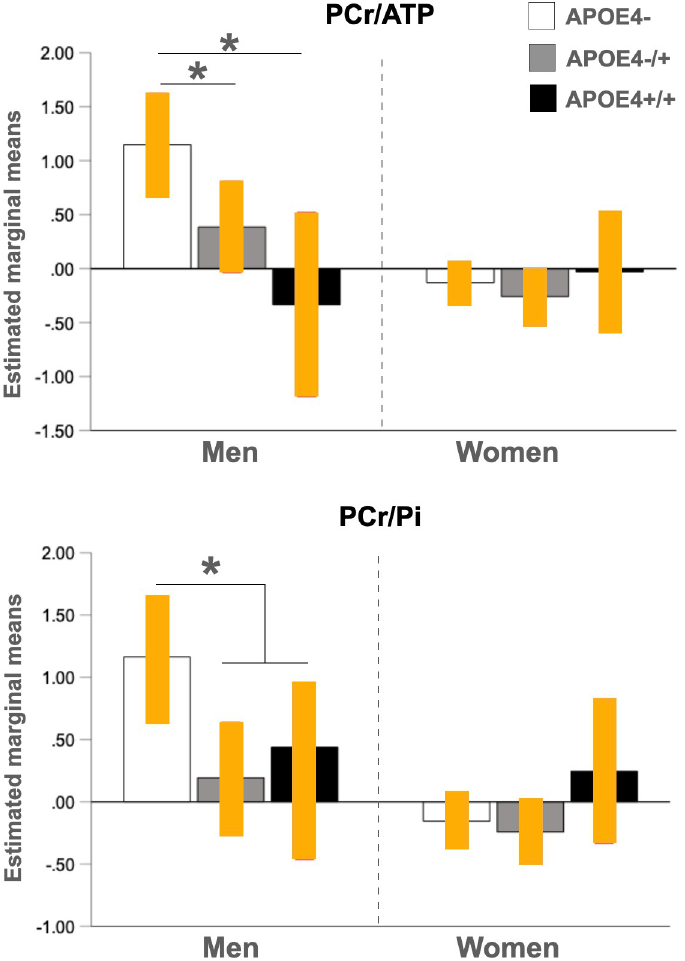
Fig 3. Effects of APOE4 dose on PCr/ATP and PCr/Pi. Plots show mean PCr/ATP and PCr/Pi measures in frontal cortex by APOE-dose group in men and women, with 95% confidence intervals (C.I.). � P < 0.05, corrected for multiple comparisons. Abbreviations: APOE4-, non-carriers; APOE4-/+, heterozygous carriers; APOE4+/+, homozygous carriers; ATP, total adenosine triphosphate; PCr, phosphocreatine; Pi, inorganic phosphate.